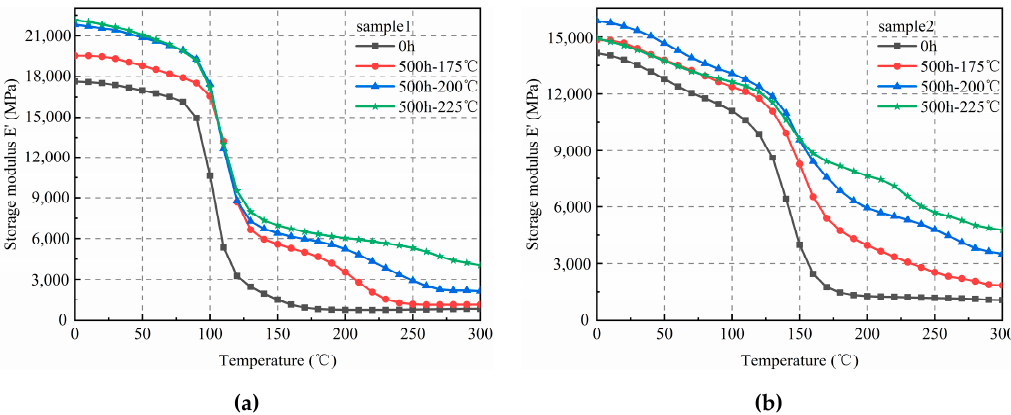
Figure 3. Elasticity modulus of EMC at 500 h of thermal aging at three different temperatures. ( a ) Sample 1; ( b ) Sample 2.